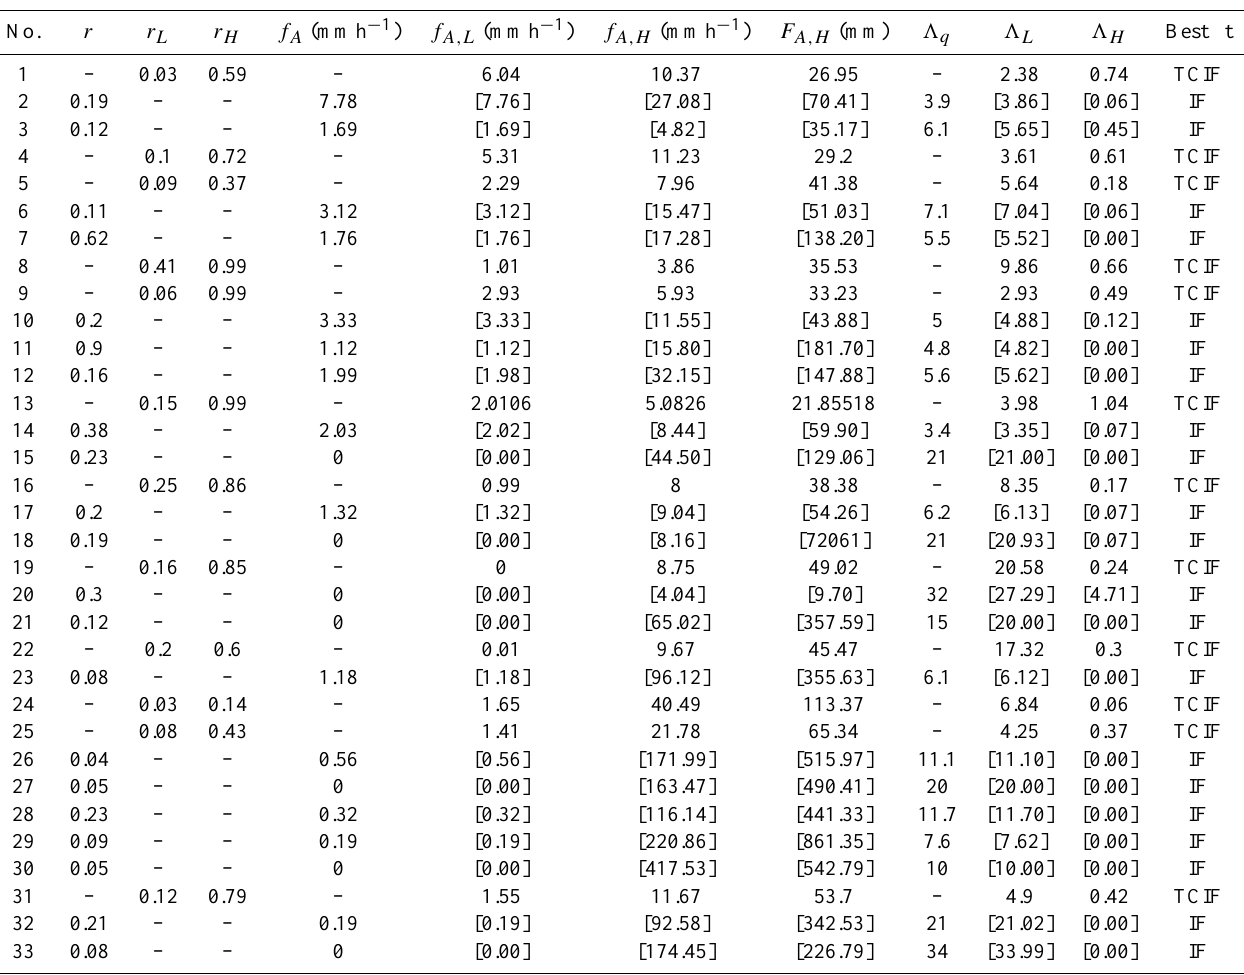
Table 4. At-site parameter estimates and selected probability